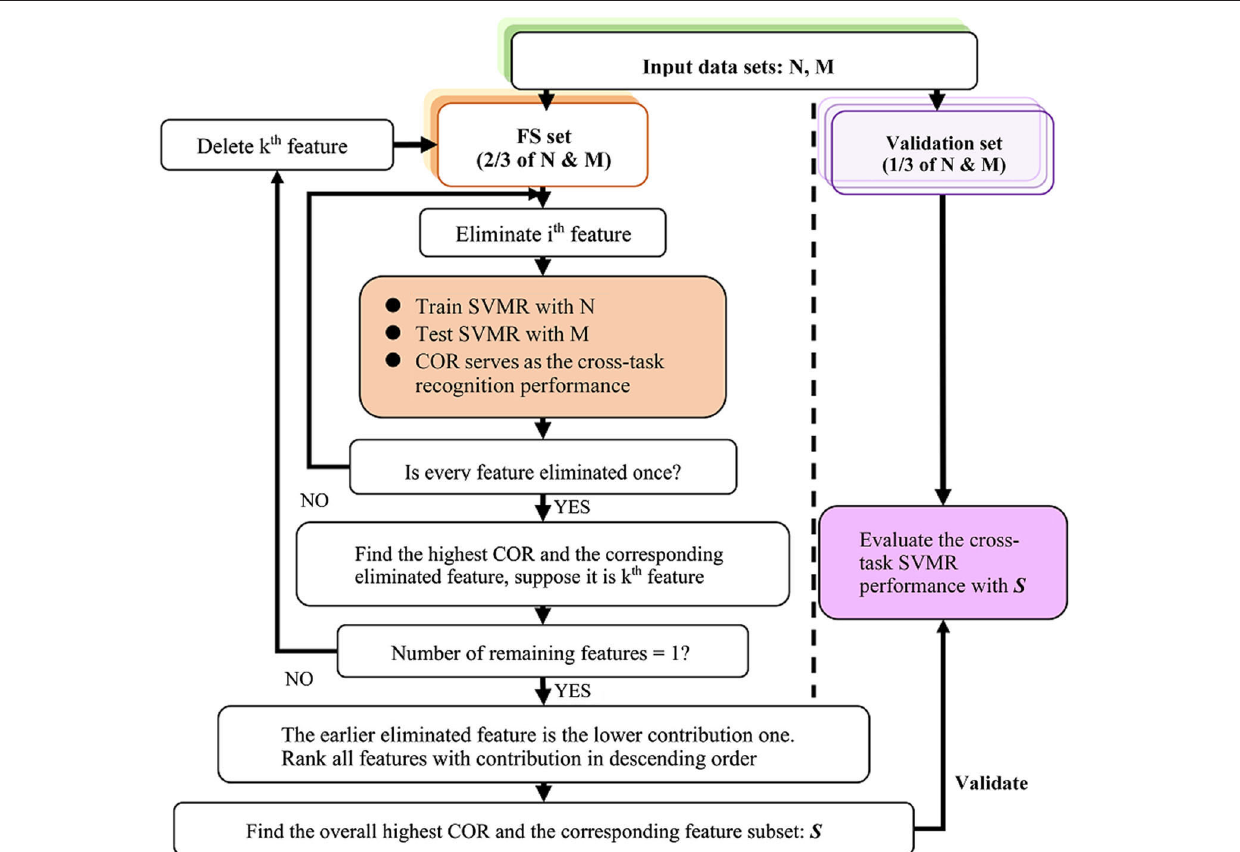
FIGURE 1 | The flow chart of the cross-task RFE algorithm